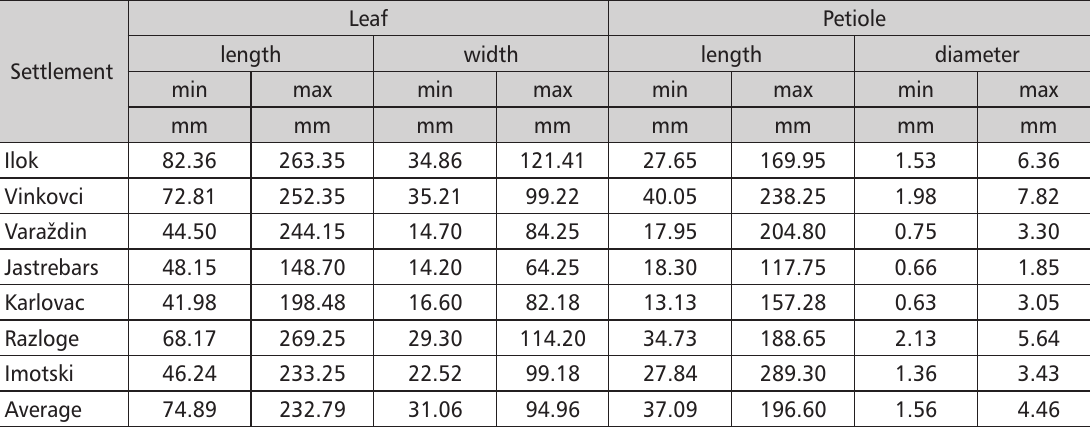
Horse chestnut leaf parameters